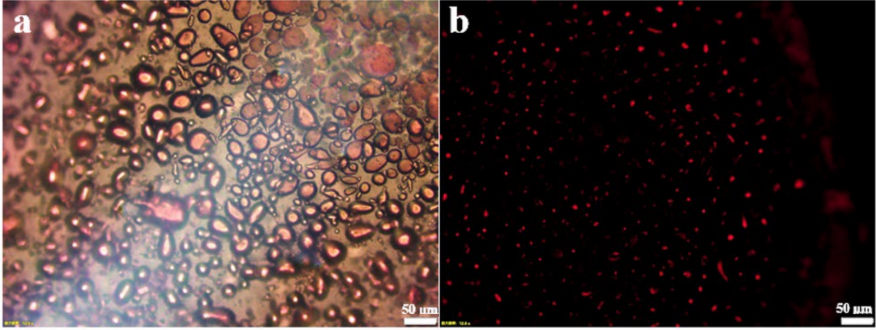
Figure 2. Fluorescence microscopy of the O/W emulsion in bright field ( a ) and dark field ( b